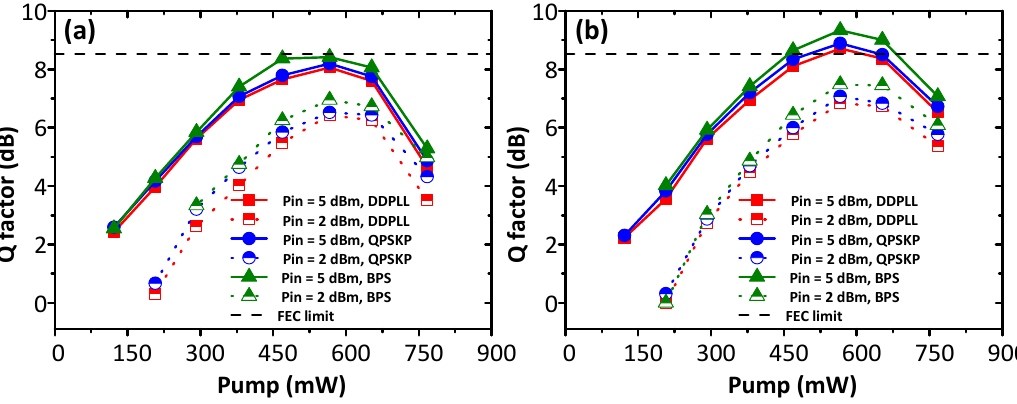
Figure 4. Q factor versus pump power for both ( a ) backward and ( b ) bidirectional pumping schemes with DDPLL, QPSKP and BPS algorithms, respectively, for launched signal powers of 5 and 2 dBm.